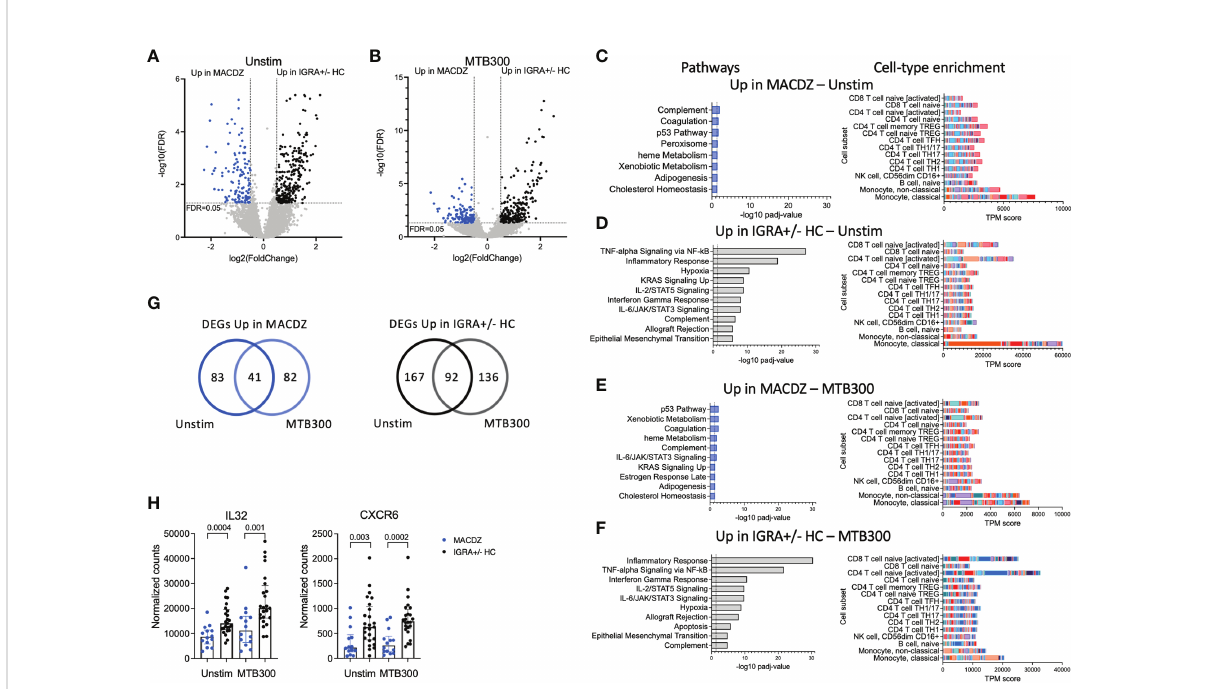
FIGURE 3 Speci fi c gene signatures in individuals with MAC disease. (A, B) Volcano plot showing differentially expressed genes in unstimulated samples (A) and MTB300 stimulated samples (B) comparing MACDZ subjects (upregulated genes shown in blue) to IGRA+/-HC individuals (upregulated genes shown in black). FDR <0.05 and log2 fold change >0.5 or <-0.5, Benjamini Hochberg corrected DESeq2 Wald test. (C – F) Pathway and cell-type enrichment (dice-database.org) for genes upregulated in unstimulated MAC samples (C) , upregulated in unstimulated IGRA+/-HC samples (D) , upregulated in MTB300 stimulated MACDZ samples (E) , and upregulated in MTB300 stimulated IGRA+/-HC samples (F) . Up to the ten most signi fi cant pathways are shown. (G) Venn-diagrams showing overlap between DEGs for unstimulated and MTB300 stimulated MACDZ samples (left) and IGRA+/-HC samples (right). (H) IL32 and CXCR6 gene expression in the unstimulated or MTB300 stimulated MACDZ and IGRA +/-HC samples. Each point represents one participant, median ± interquartile range is shown. Two-tailed Mann-Whitney